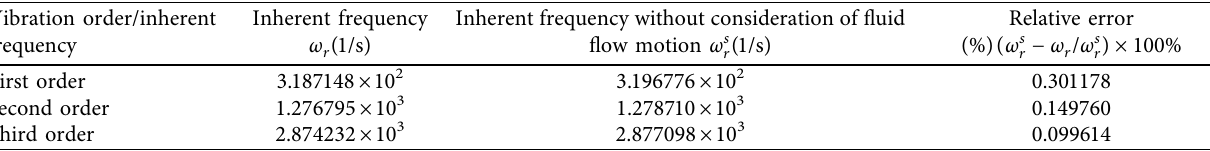
Table 1: The inherent frequency of first three orders of hydraulic pipeline system ( ω fluid flow motion ( ω s r ) and relative error.